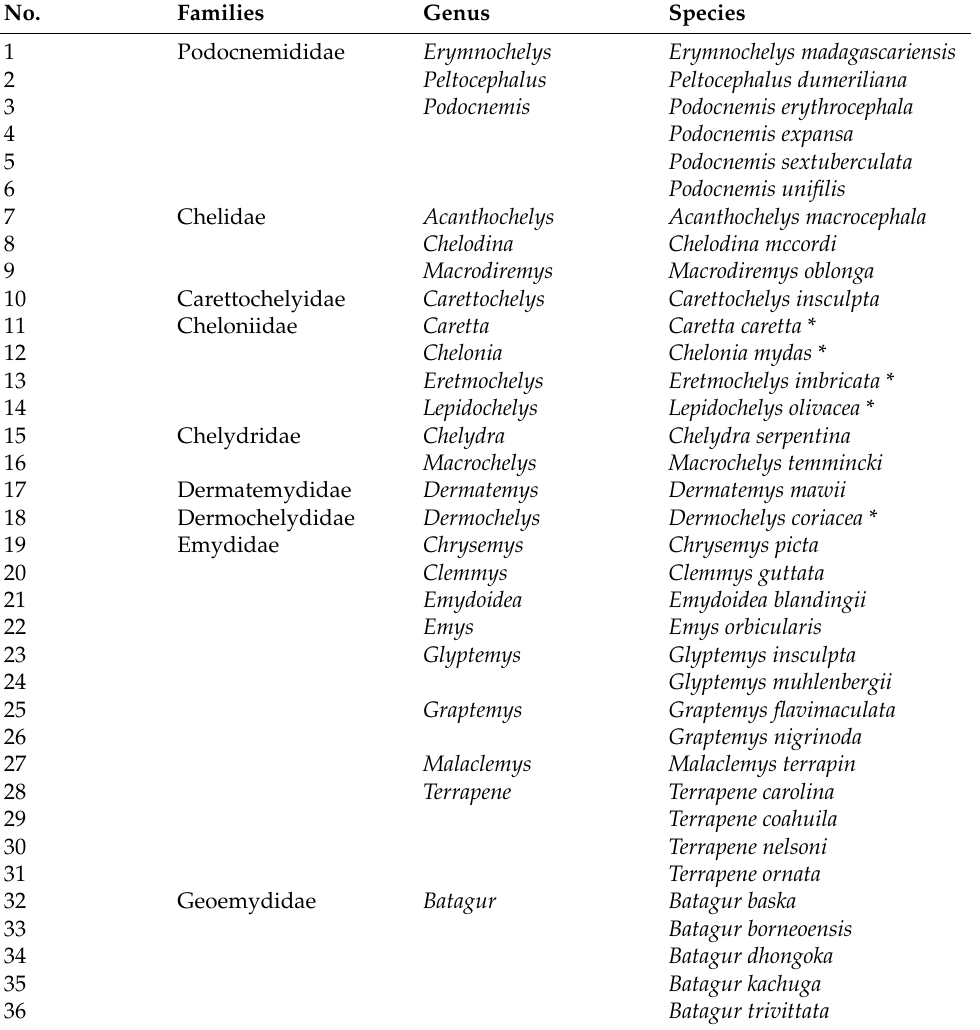
Table A1. Turtle Breeding Species Investigated in Various